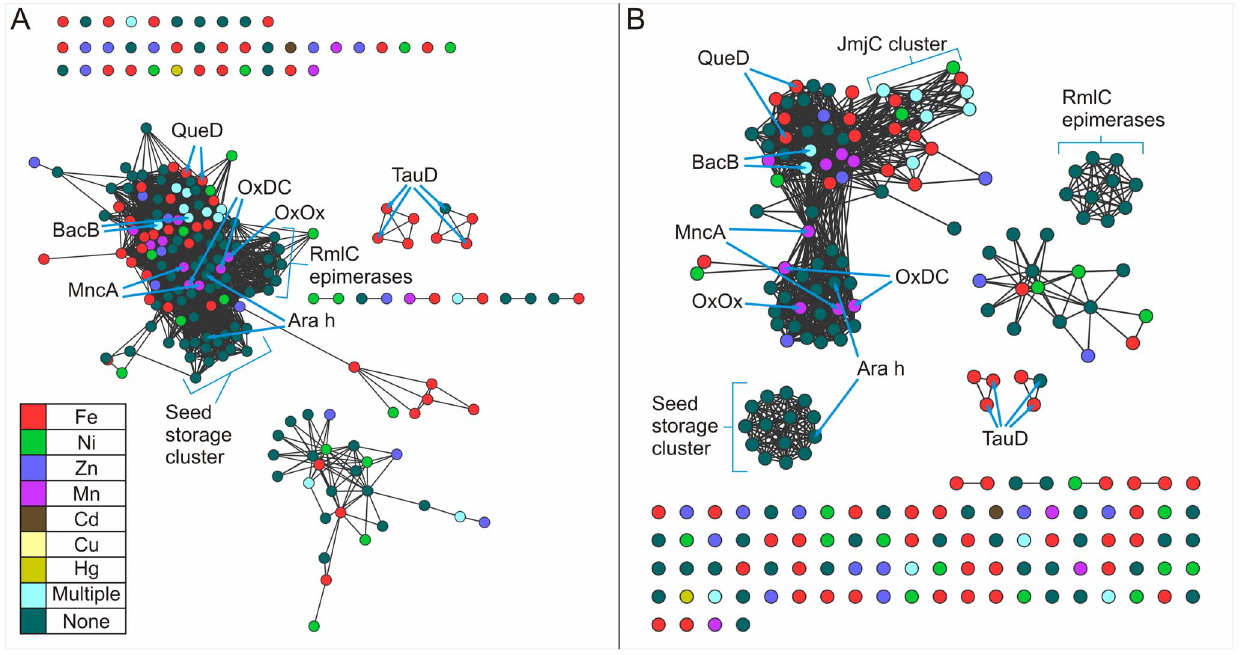
Figure 4. Structure similarity networks of cupin domains colored by metal ligand. Pairwise similarities for a non-redundant set of 213 domains from the Pfam cupin clan (CL0029) were calculated using TM-align [37]. Each node represents a domain. Nodes were arranged using the yfiles organic layout of of Cytoscape version 3.0. A. Edges between nodes were drawn only if the average TM-score . 0.53 for that edge. At this cutoff, the average r.m.s.d. is 1.73 A˚ with 74.2 C a atoms aligned. B. Edges between nodes were drawn only if the average TM-score . 0.65 for that edge. At this cutoff, the average r.m.s.d. is 1.42 A˚ with 80.1 C a atoms aligned.